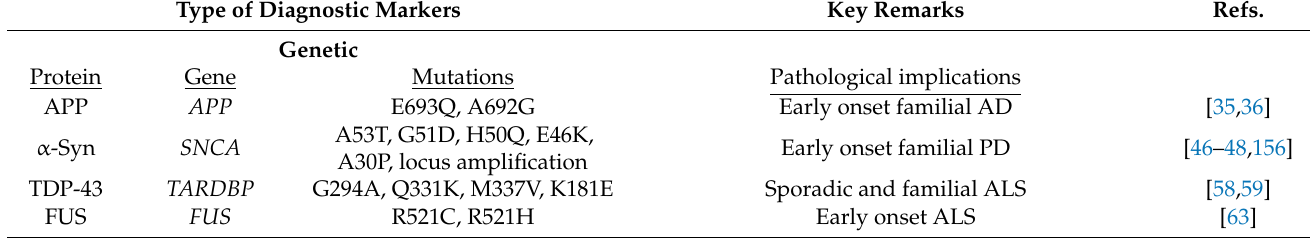
Table 2. Main current and potential diagnostic markers of neurodegenerative diseases with main references. Type of Diagnostic